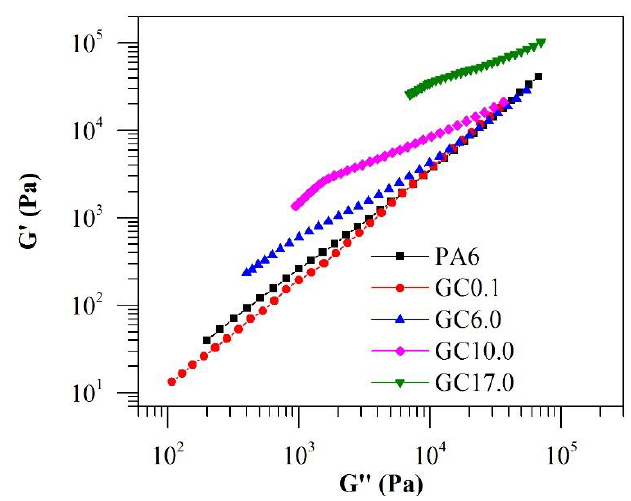
Figure 4. Change in α with increasing GNP content.